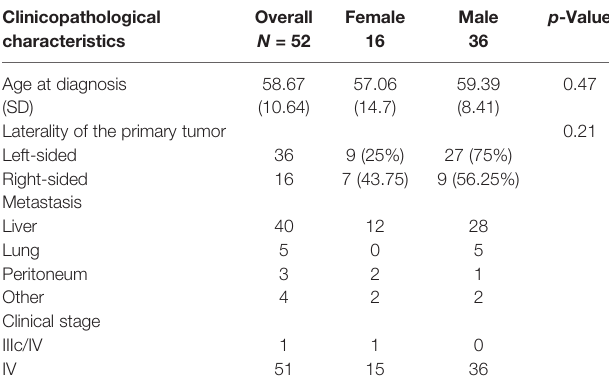
TABLE 1 | Clinicopathological characteristics of patients in the entire cohort and by